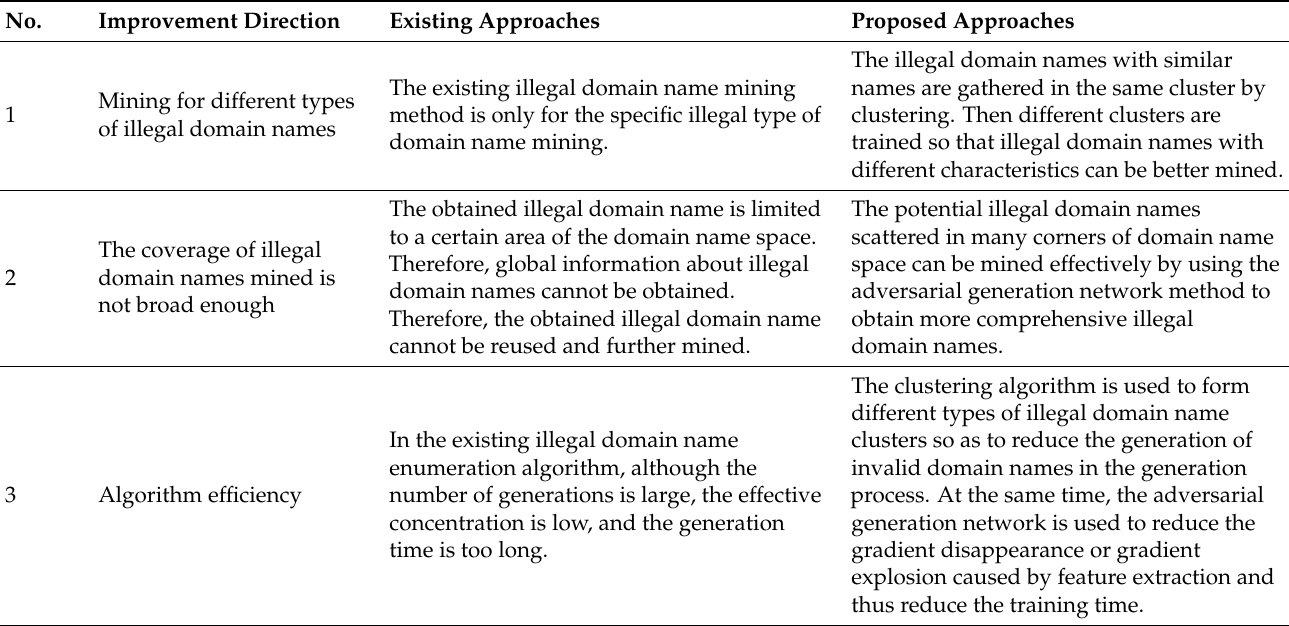
Table 1. Comparison of existing approaches and proposed approaches.